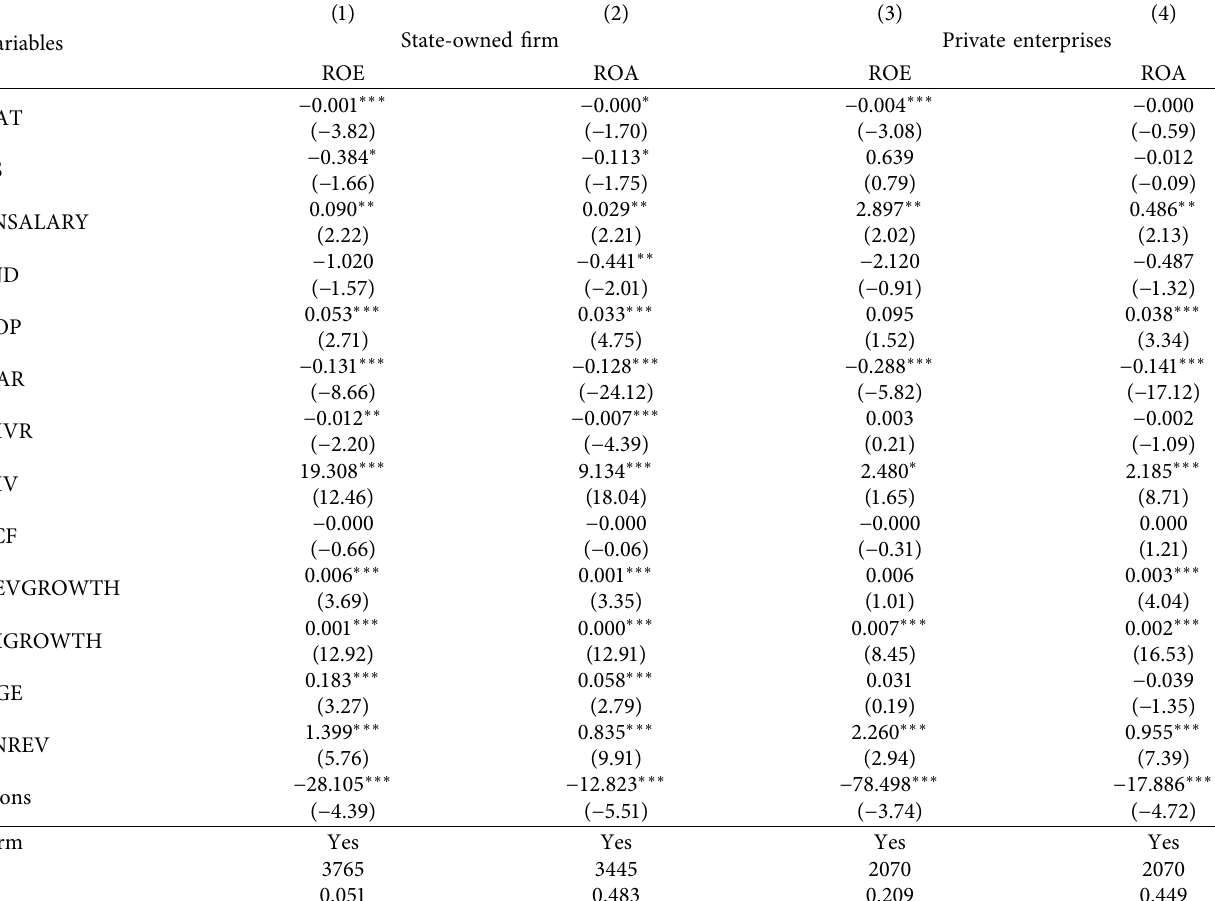
Table 7: Robustness test of the effect of agency costs on corporate sustainable development.